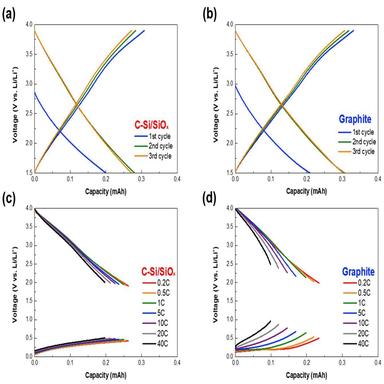
Galvanostatic voltage profiles of the LIC full cells prepared by (a) the pre-lithiated C-coated Si/SiOx nanosphere electrode and (b) the pre-lithiated graphite electrode in a voltage range of 1.5–3.9 V vs. Li/Liþ at a constant current density of 0.1C (1C ¼ 85 mA g 1 ), and rate capabilities of the LIC full cells prepared by (c) the pre-lithiated C-coated Si/SiOx nanosphere and (d) pre-lithiated graphite electrodes at different current densities of 0.2, 0.5, 1, 5, 10, 20, 40C (1C ¼ 85 mA g 1 ).